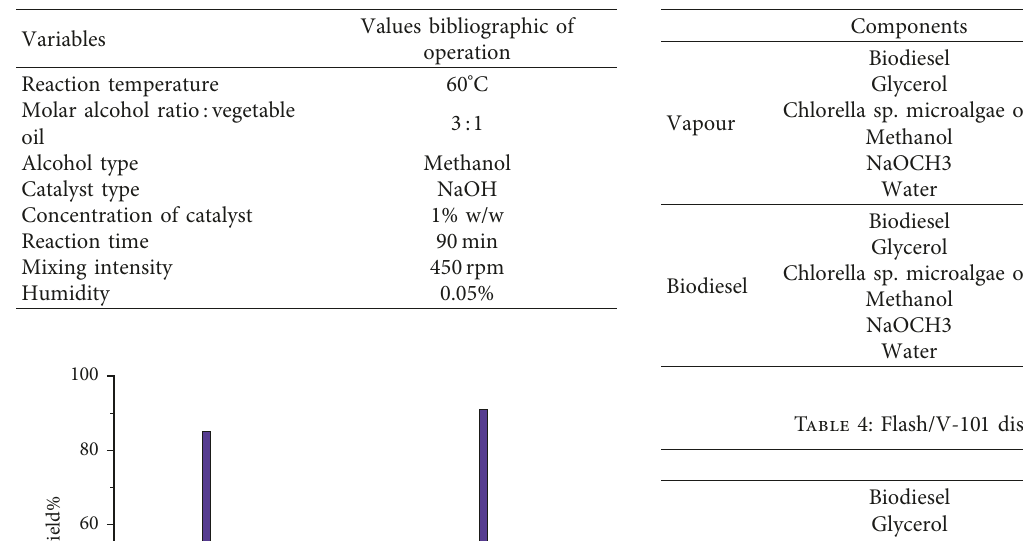
Table 3: Flash distiller/V-101 results.